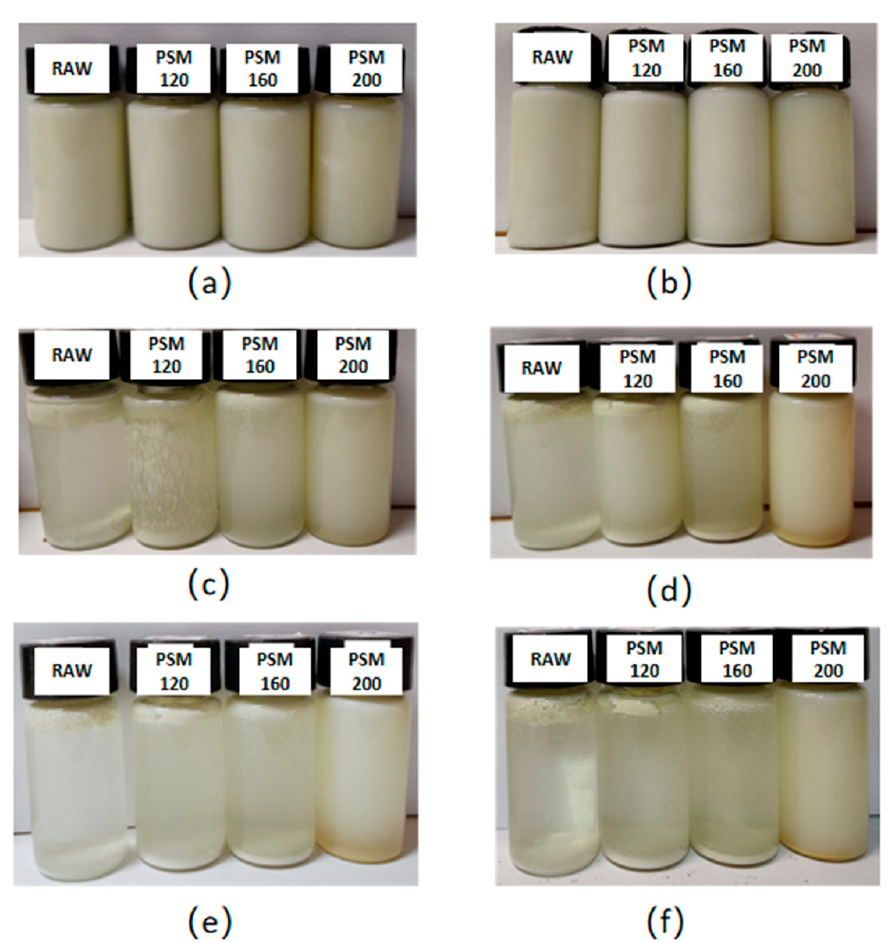
Figure 5. Appearance of PSM after storage for different times. ( a – f ) Storage for 1, 3, 7, 14, 21, and 30 days, respectively. RAW: raw pumpkin seeds, PSM120: pumpkin seeds roasted at 120 °C, PSM160: pumpkin seeds roasted at 160 °C, and PSM200: pumpkin seeds roasted at 200 °C.